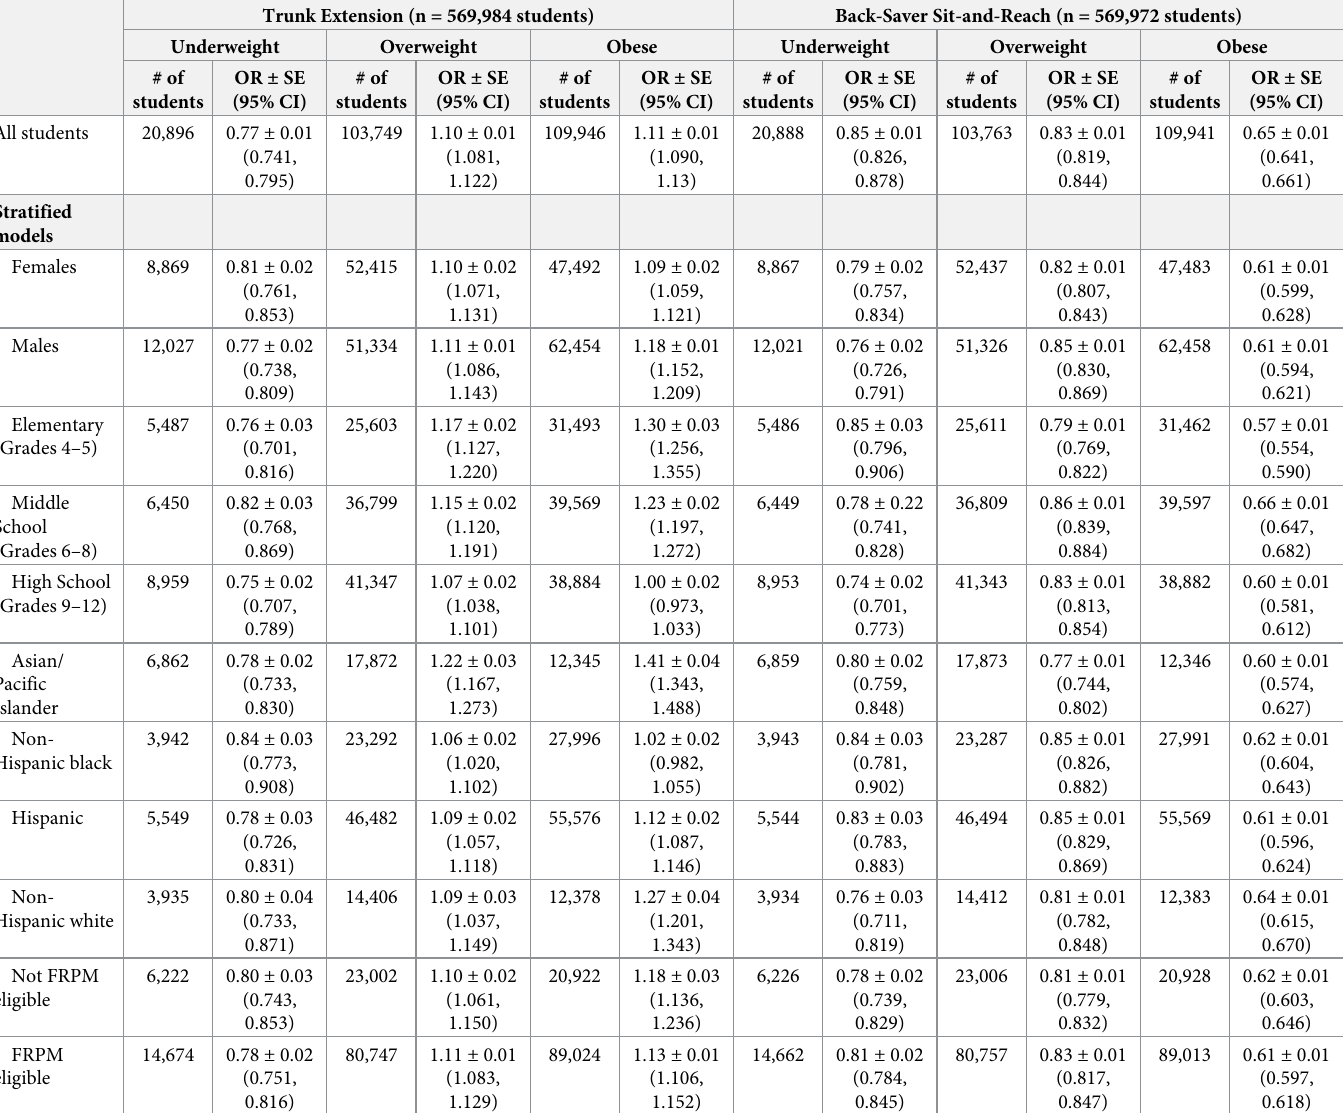
Table 2. Adjusted associations A between student weight status B and odds of being in the healthy fitness zone C for the FITNESSGRAM 1 tests for flexibility among New York City 4 th -12 th grade public school students, 2017–18, by student-level demographic characteristics. Trunk Extension (n = 569,984 students) Back-Saver Sit-and-Reach (n = 569,972 students)